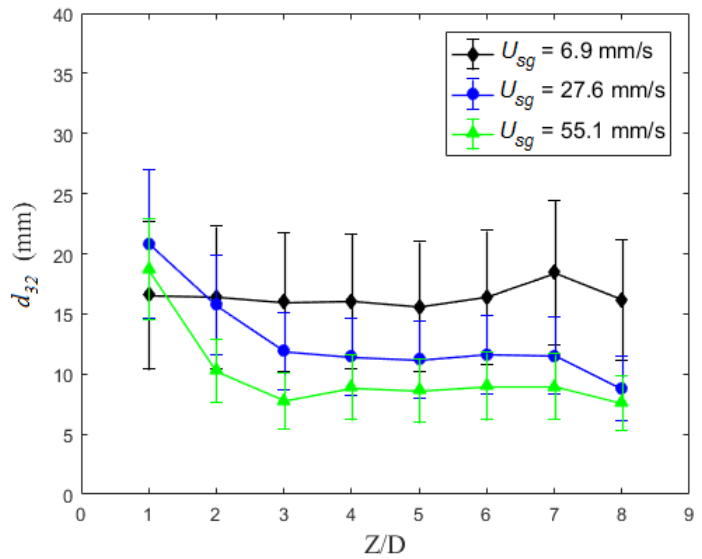
Figure 4. Sauter mean diameter ( d 32 ) plotted versus the scaled vertical distance above the injection location. Each data point is the average of 10 repetitions, and the error bars are the standard deviation of the mean ( P m = 600 kPa, T c = 21 ± 1 °C, D = 102 mm, d inj = 1.6 mm).